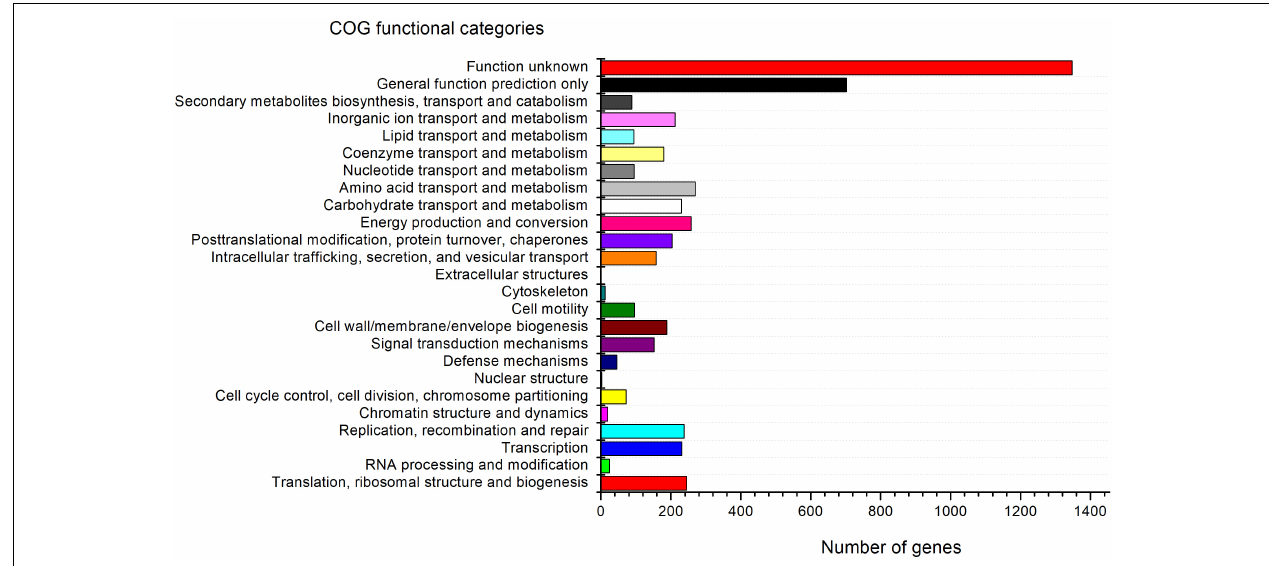
FIGURE 3 | Clusters of Orthologous Group (COG) functional classification of proteins in the genome of strain G-1-1-14 T .